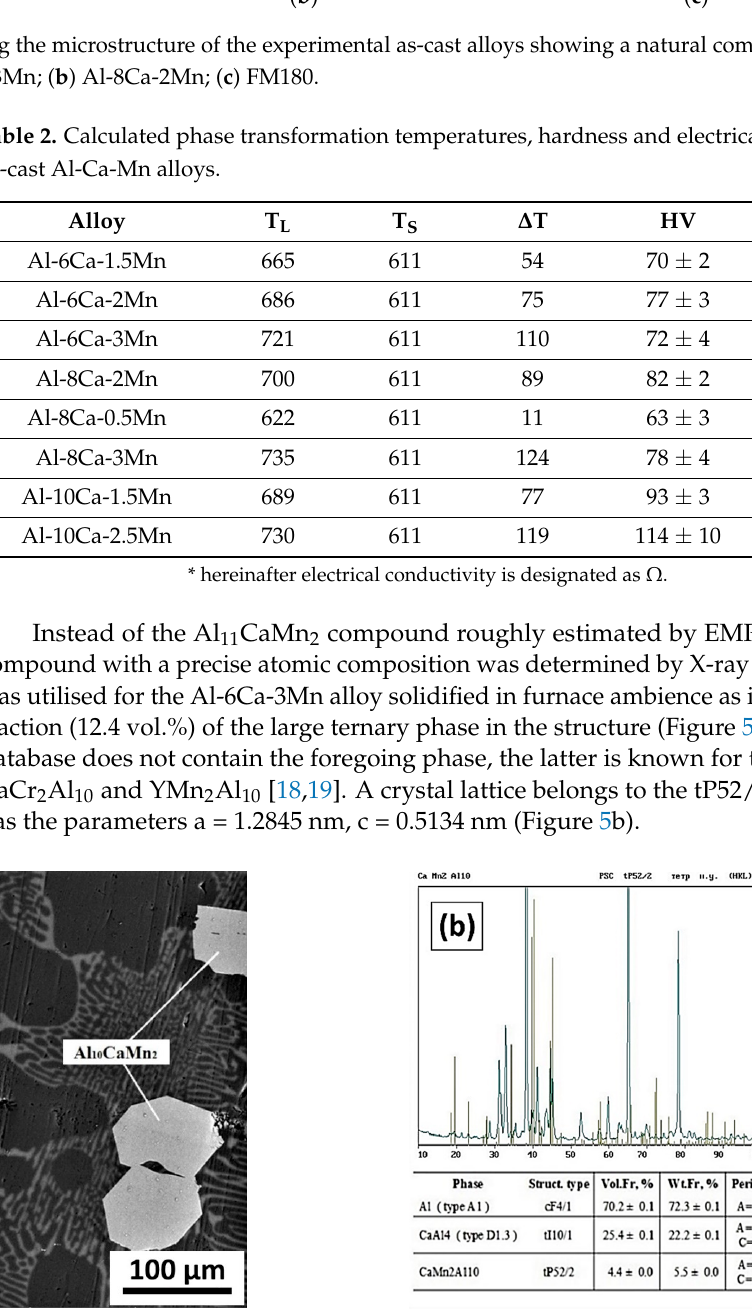
Figure 5. SEM images showing the Al 10 Mn 2 Ca crystals appeared in the Al-6Ca-3Mn alloy after furnace cooling ( a ) and X-ray analysis data identified the Al 10 Mn 2 Ca compound ( b ) .